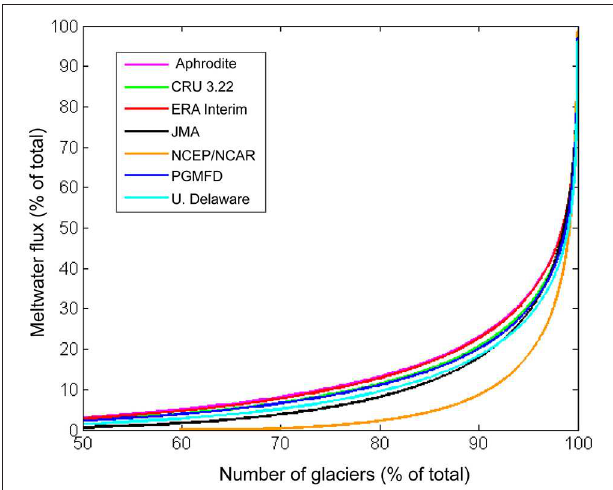
FIGURE 10 | Projected percentage change in meltwater flux, relative to the mean meltwater flux for the 1979–2007 period, assuming warming of 2–4 ◦ C by 2100 AD (IPCC, 2013), and a constant rate of glacier area decrease of 0.1–0.4% yr − 1 (i.e., 6–26% reduction in glacier extents by 2100 AD) (Bolch et al.,